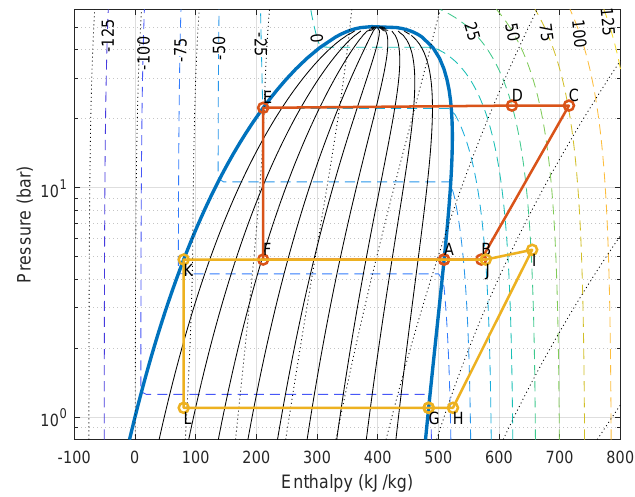
Figure 3. A p - h diagram for the R1150-circuits in the Optimized